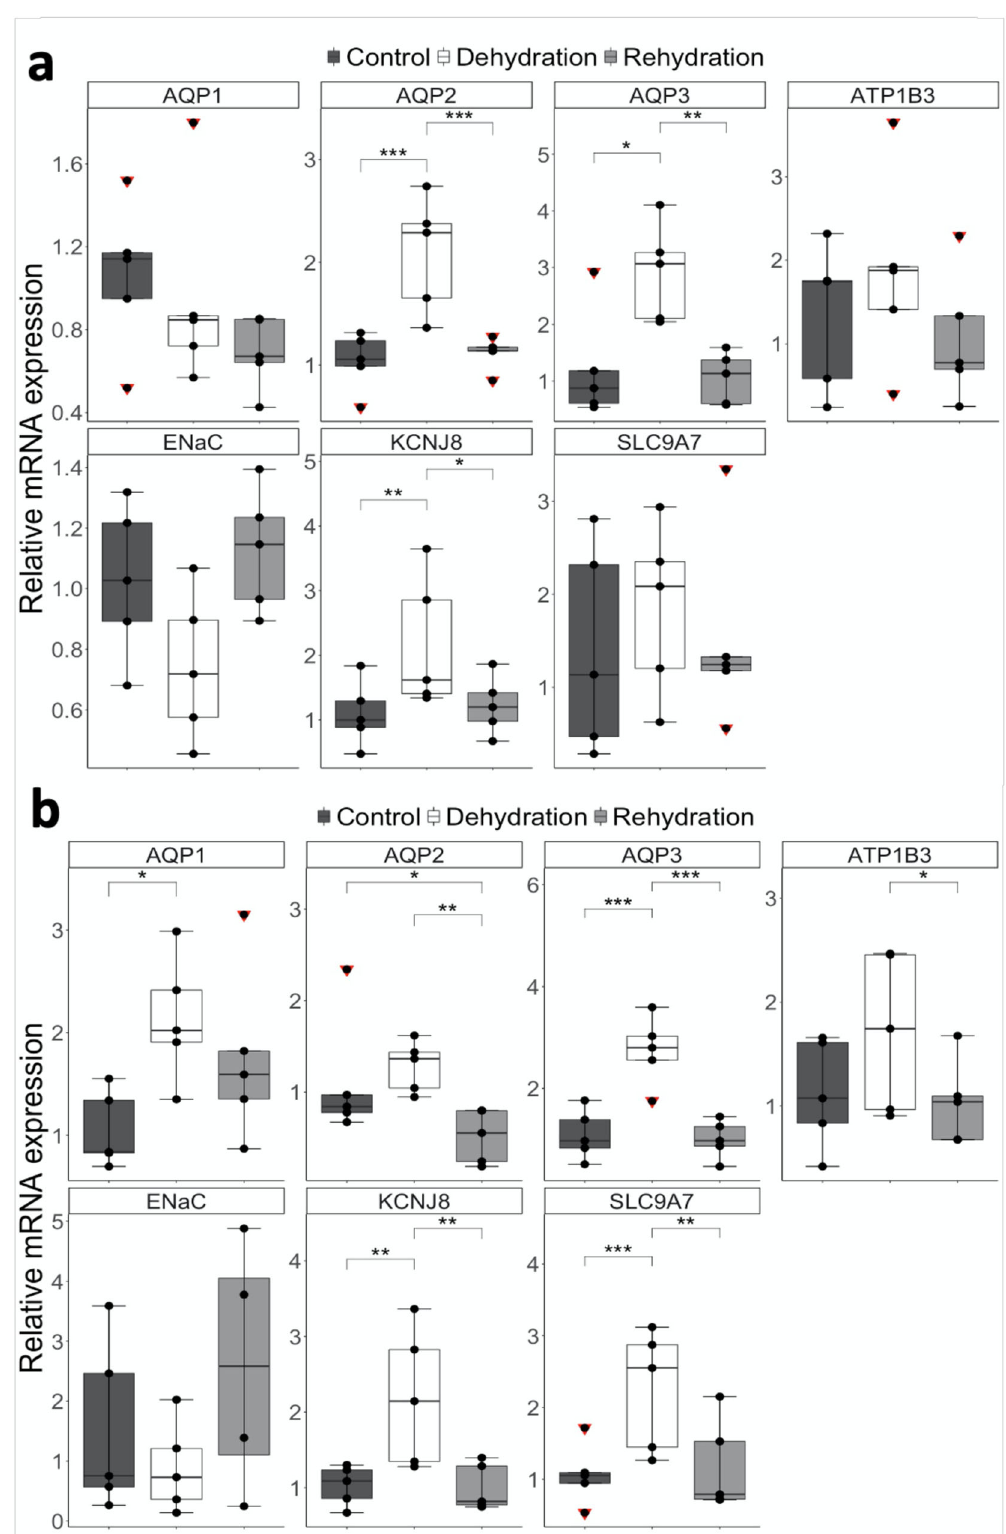
Fig. 7 RT-qPCR validation of genes coding for ion transporters and aquaporins. Relative changes in gene expression of key genes involved in solute and water transport in the Arabian camel kidney a medulla and b cortex after severe dehydration and acute rehydration compared to controls. Comparison of the means by one-way ANOVA (Turkey ’ s post hoc correction). The boxplots are presented with the S.E.M. ( n = 5), centre lines show median, box edges delineate 25th and 75th percentiles and bars extend to minimum and maximum values. Individual data points represent biologically independent samples and data points within red triangles denote outliers, all the outliers highlighted were included for the statistical analyses. *** p adj < 0.001, ** p adj < 0.01, * p adj <